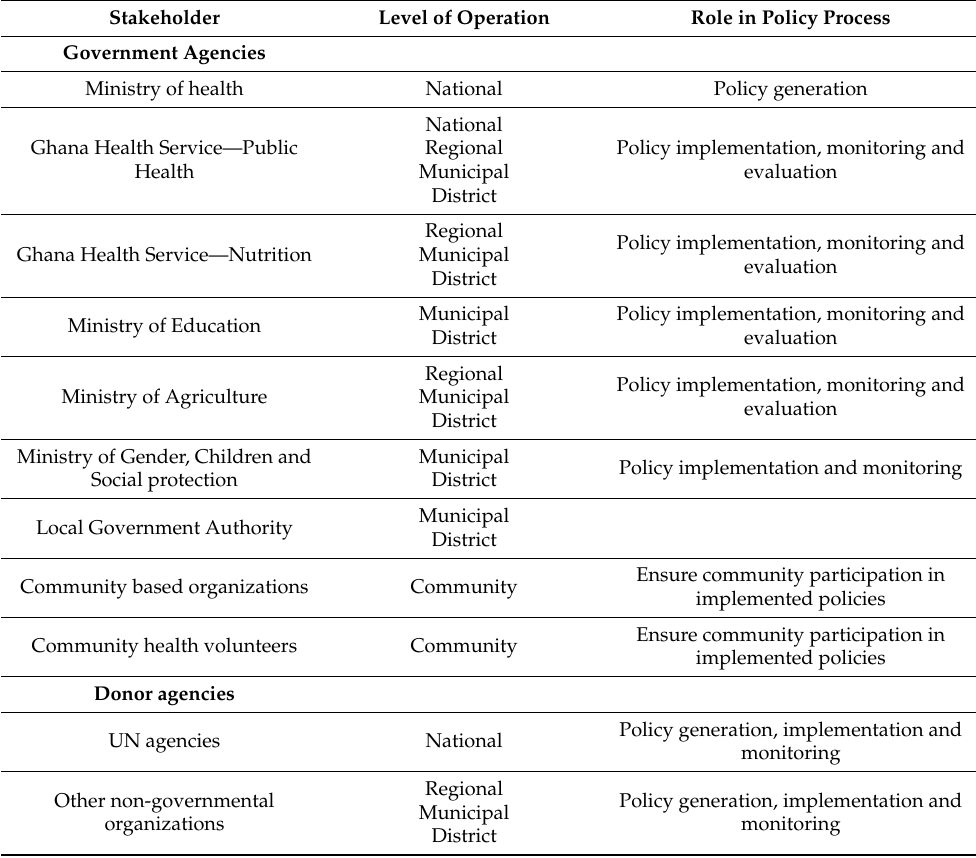
Table 1. Stakholders level of operation and role in the policy